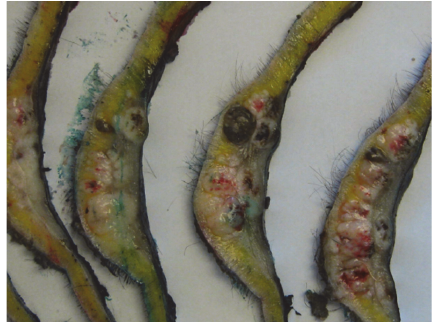
Figure 2: Macroscopic tumour histopathology showing in-transit